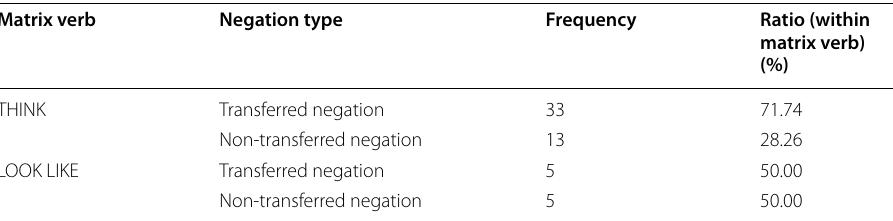
Table 5 Distribution of negation types in Easson Corpus of transferred negation Matrix